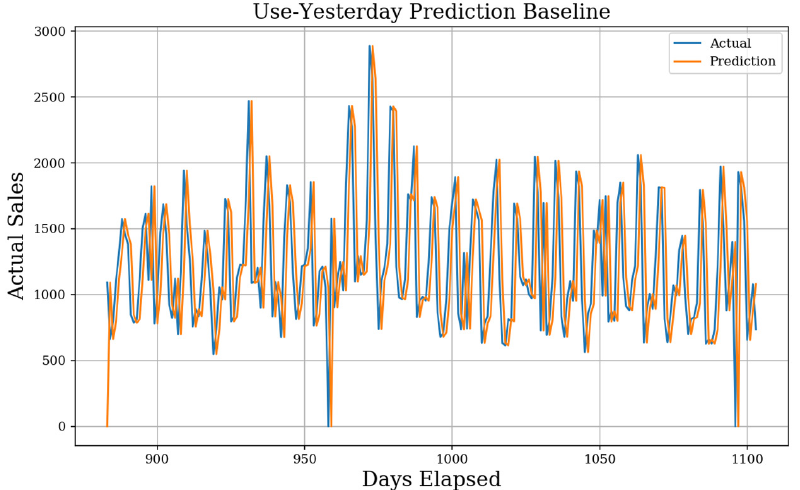
Figure 9. Use-Yesterday Prediction. The most basic possible prediction model assumes that predicted day D (t) is exactly the previous day D (t − 1). The MAE baseline generated is 403, and the prediction shape does not fit the test set well.